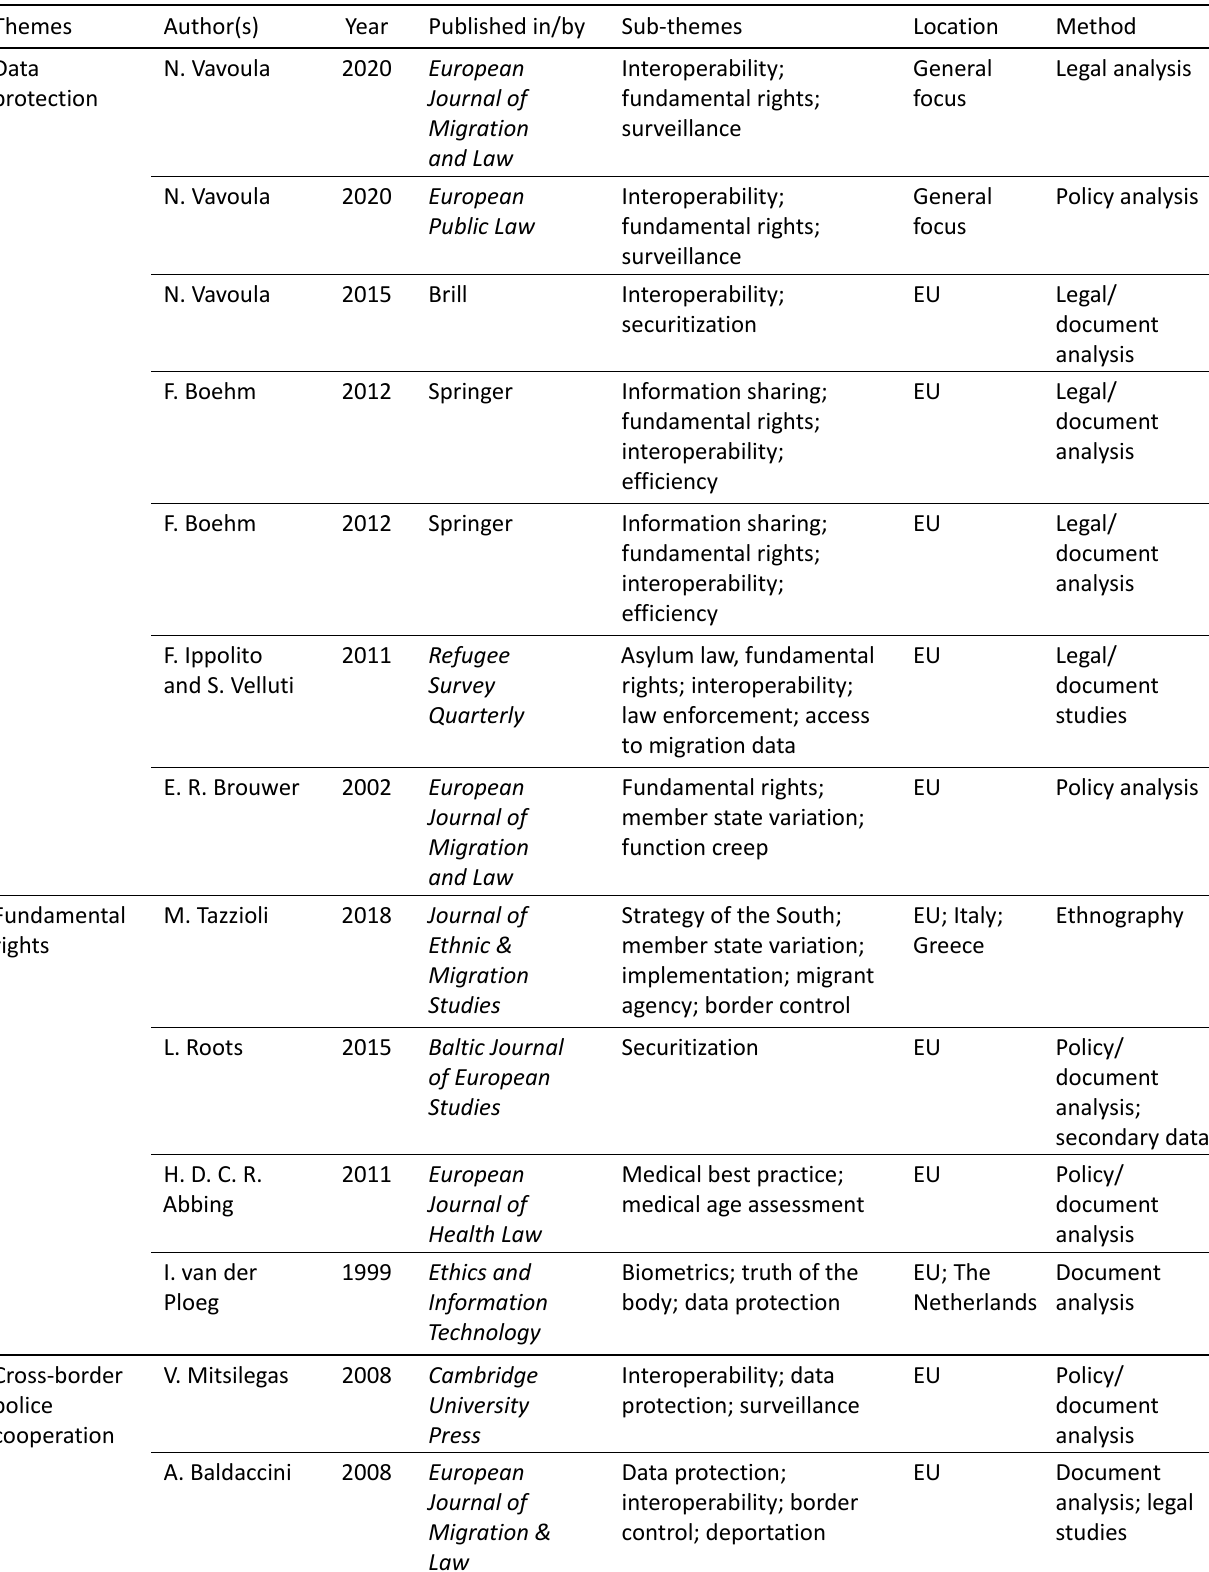
Table 1. (Cont.) Themes and key publications.